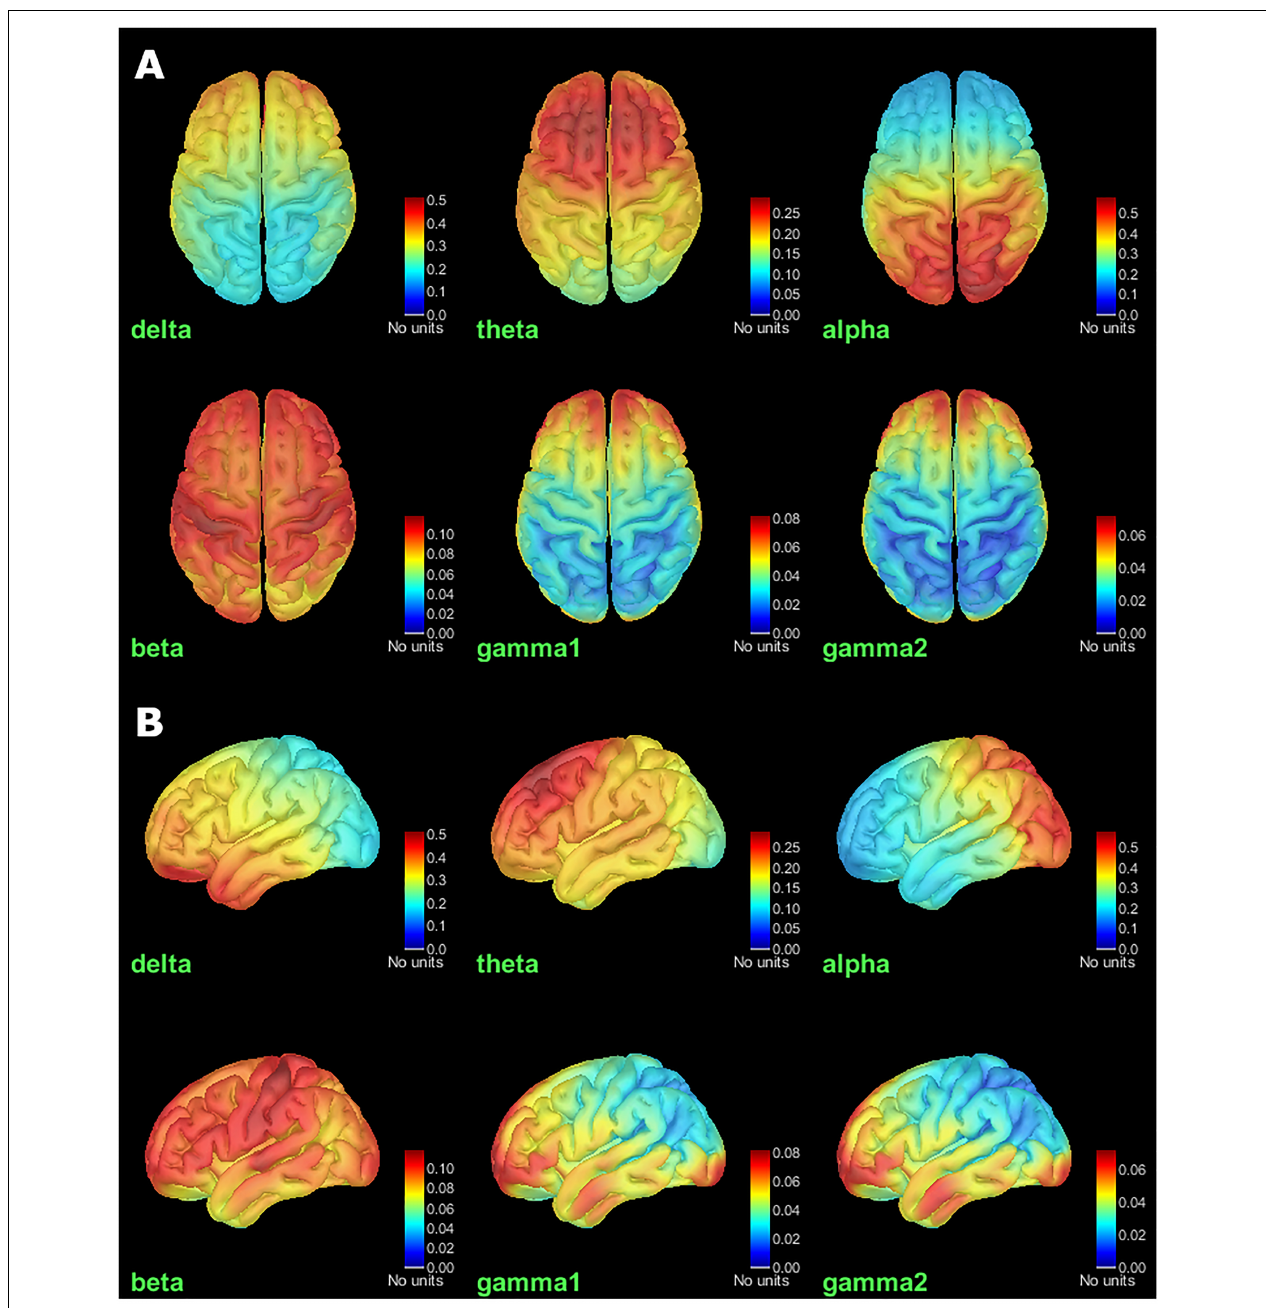
FIGURE 4 | Group average of relative PSD maps for all tested frequency bands. (A) Top View. (B) Left view. Values range between 0 and 1, indicating the power of cortical signals relatively to the total signal power across the frequency spectrum.